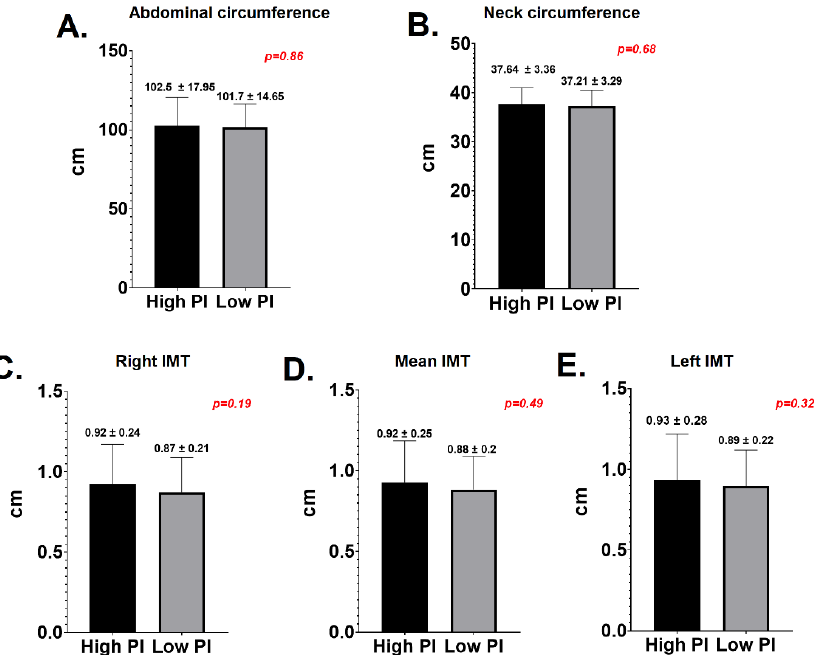
Figure 4. Periodontal diseases and markers of subclinical atherosclerosis. ( A ) Abdominal circumference; ( B ) neck circumfer- ence; ( C ) right intima media thickness; ( D ) mean intima media thickness; ( E ) left intima media